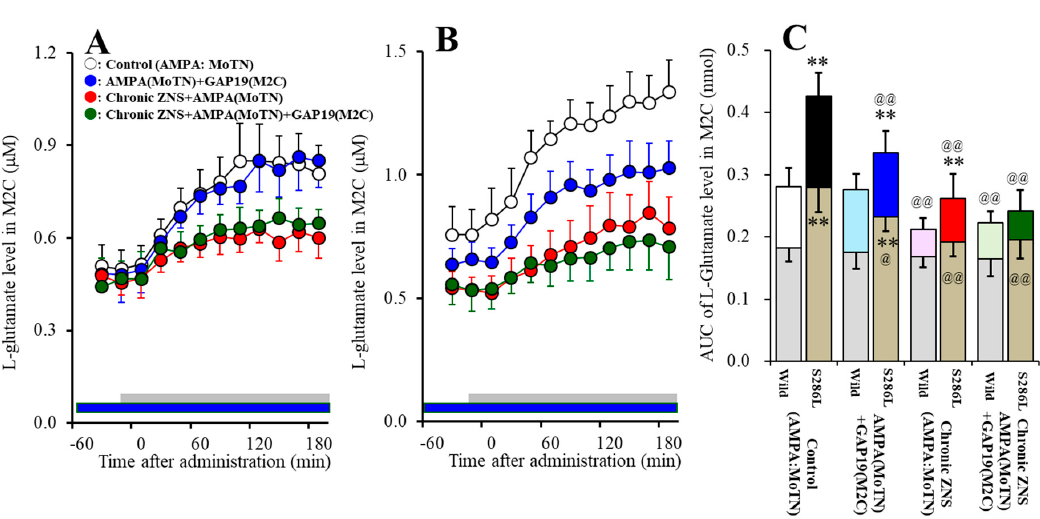
Figure 6. Interaction between local administration of GAP19 (Cx43 inhibitor) into the M2C and subchronic administration of therapeutic-relevant dose of ZNS (40 mg / kg / day for 7 days) on AMPA-evoked L-glutamate release in the M2C of wild-type ( A ) and S286L-TG ( B ). Rats were subchronically administered a therapeutic-relevant dose of ZNS (chronic ZNS or Chronic ZNS + GAP19) or ZNS free (control or AMPA + GAP19) using a subcutaneous osmotic pump. Perfusion medium in the M2C was commenced with MRS containing with (AMPA + GAP19 and chronic ZNS + GAP19) or without (control and chronic ZNS) 100 µ M GAP19. After the stabilization of L-glutamate level in the M2C, the perfusion medium in the MoTN was switched from MRS to MRS containing 100 µ M AMPA for 180 min. Ordinates indicate mean extracellular L-glutamate level ( µ M) (N = 6), and abscissas indicate time after AMPA-evoked stimulation (min). Blue bars indicate the perfusion with 100 µ M GAP19 into the M2C. Gray bars indicate the perfusion with 100 µ M AMPA into the MoTN. ( C ) indicates the AUC value of extracellular L-glutamate level (nmol) before (basal extracellular L-glutamate level) and during perfusion with AMPA (from 20 to 180 min) of Figure 6A,B. Gray columns in Figure 6C indicate the AUC values of basal extracellular levels of L-glutamate in Figure 6A,B. ** P < 0.01;